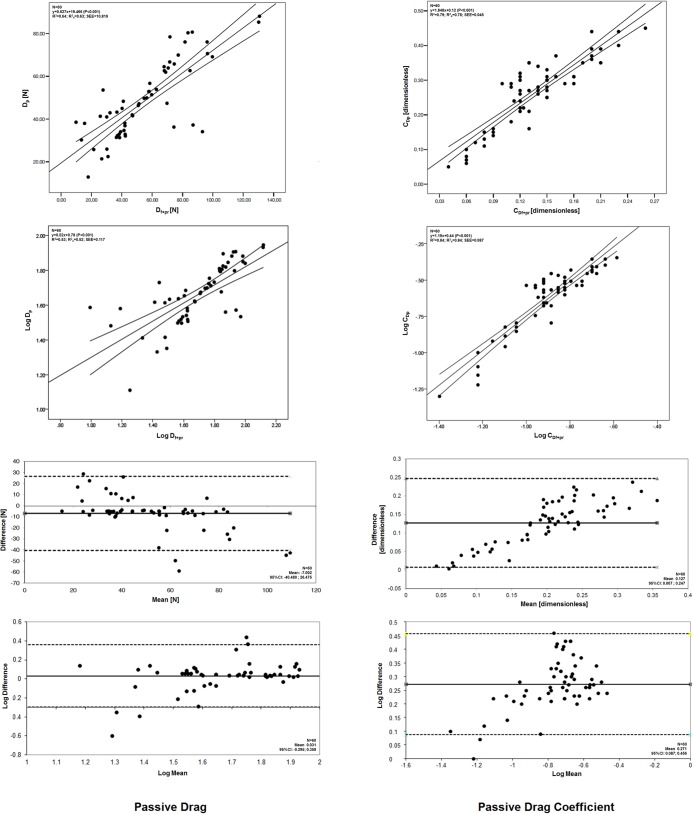
Comparison between experimental and analytical procedures to assess the passive drag (Dp and Df+pr, respectively) and the passive drag coefficient (CDp and CDf+pr, respectively) in absolute unit and after logarithmic transformation.